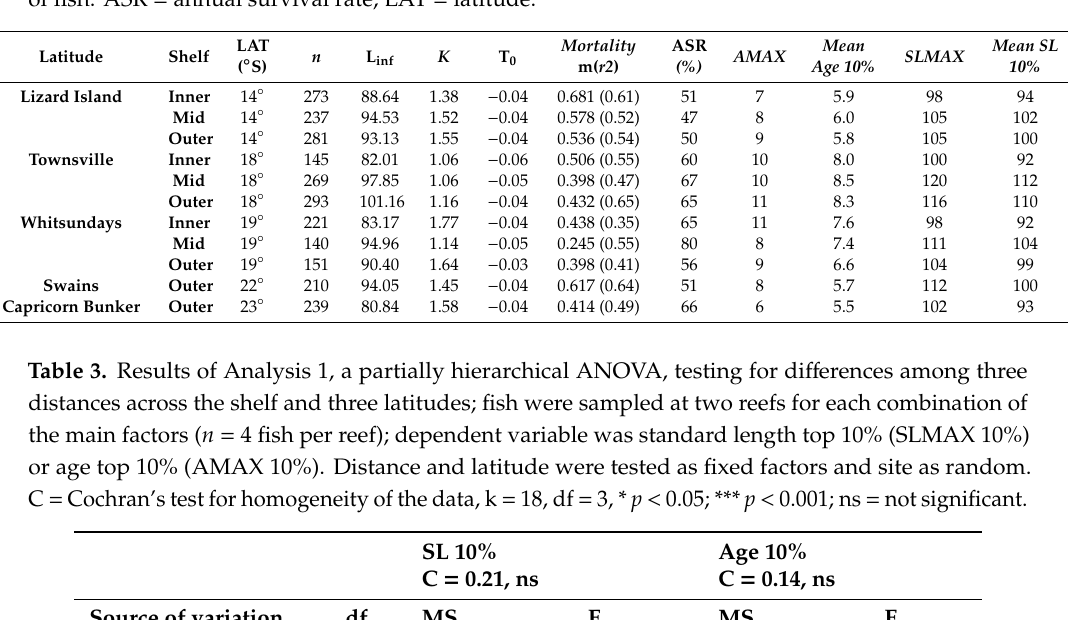
Table 2. Parameters from von Bertalan ff y growth models and instantaneous mortality on the fishes collected from di ff erent distances across the shelf and latitude strata. The age max (AMAX; in years) and standard length max (SLMAX; in mm) are provided, as well as mean age and size for the top 10% of fish. ASR = annual survival rate; LAT = latitude.